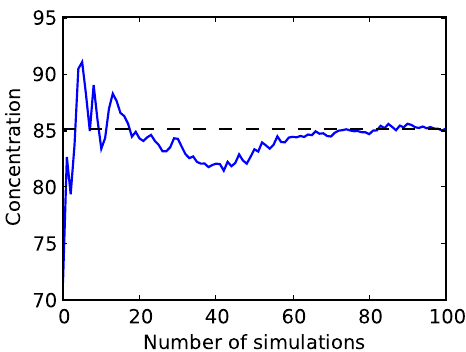
Fig. 2. The empirical mean of the ozone peaks averaged over all stations of network 1 and during 2001. It seems to have converged after about 70